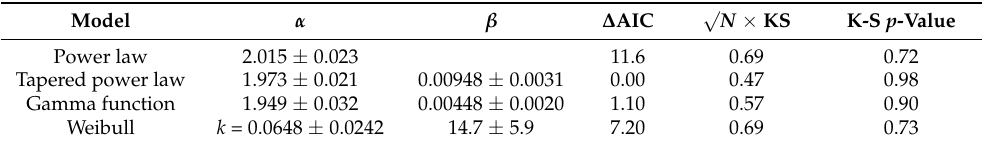
Table 1. Derived parameters for X-ray fluence distributions ( F 0 = 1 × 10 − 2 J m − 2 , N = 1945). See text for details.